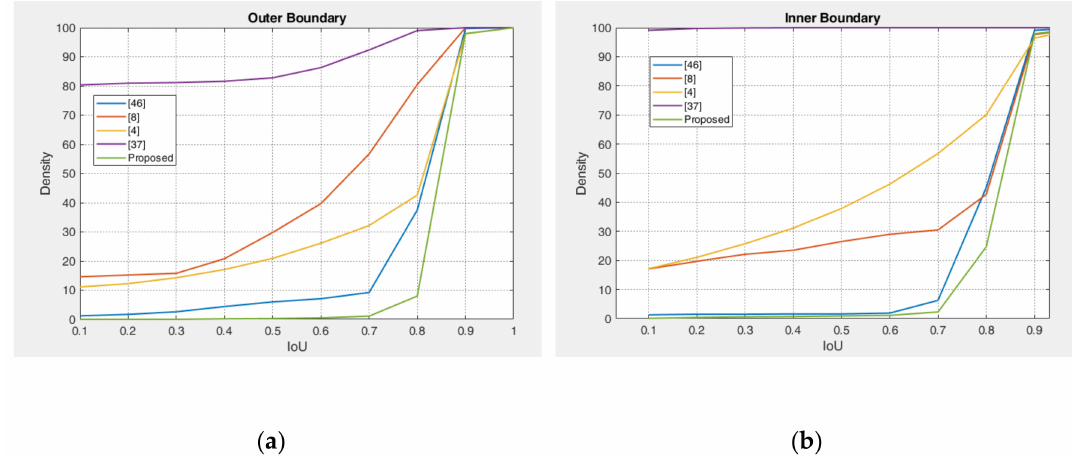
Figure 13. IoU cumulative distribution of proposed method on CASIA-Iris-Thousands database compare with other works. ( a ) Outer boundary distribution; ( b ) inner boundary